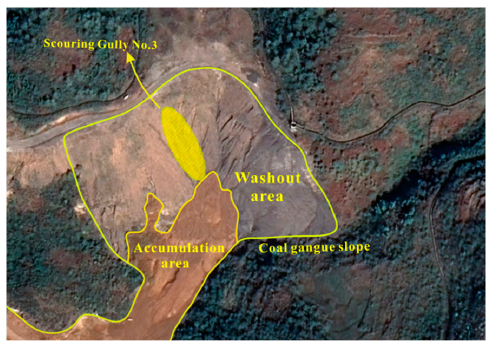
Figure 1. Satellite map of the studied coal gangue area in the Guizhou Province (China).